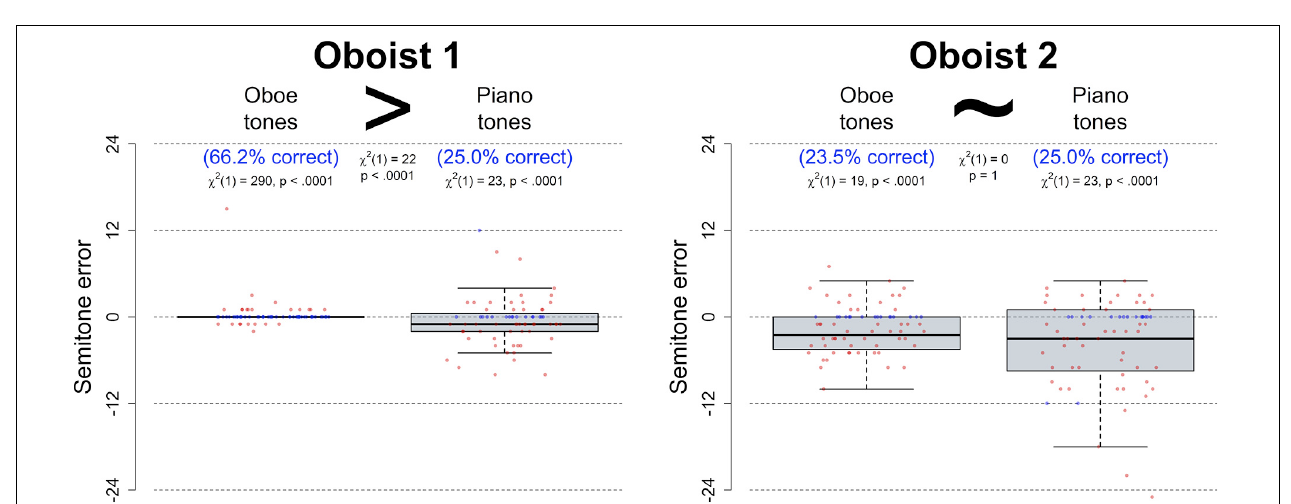
FIGURE 2 | Experimental design for Experiment A, consisting of four blocks of 34 randomized tones each. Two blocks contained piano tones, while the other two contained oboe tones. Each oboist heard the tones that she herself had recorded on her own instrument.